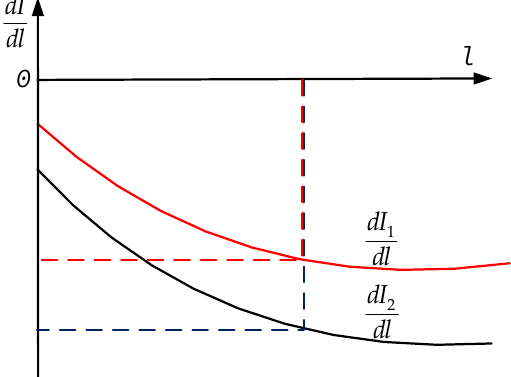
Figure 5. The functional relationship between dI / dl and l . Figure 5 . The functional relationship between